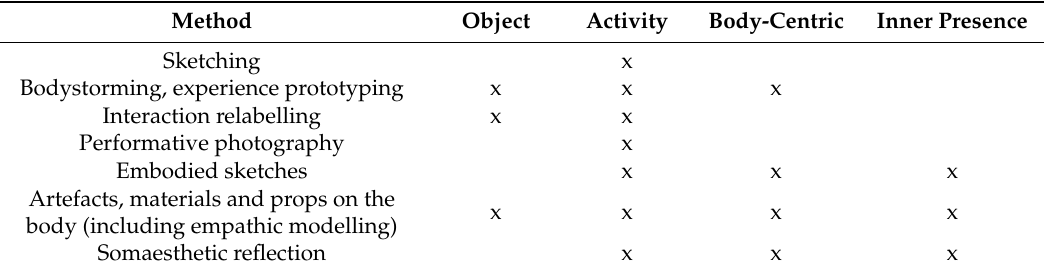
Table 1. Ideation methods and their